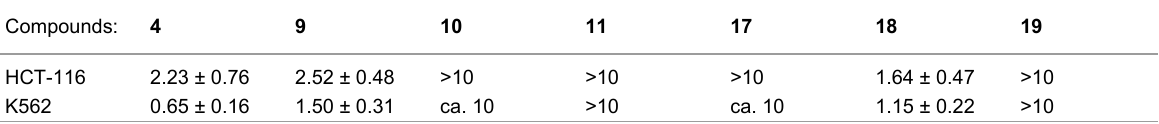
Table 2: Cytotoxicity tests on HCT-116 human colon carcinoma and K562 myelogenous leukemia cells (showing IC 50 : half inhibitory concentrations, µg/mL) a,b .